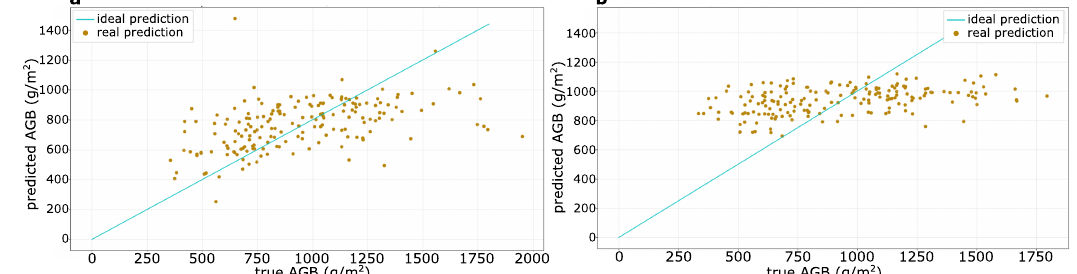
Figure 11. The AGB predictions for the wheat crops at a 0.35 m 2 resolution that were produced by the ERT model compared to those that were produced by the linear model (baseline): ( a ) the regression performance of the ERT model using the testing dataset ( R 2 = 0.20; RMSE = 288 g/m 2 ; MAE = 216 g/m 2 ; MAPE = 23%); ( b ) the regression performance of the linear model (baseline) using the testing dataset ( R 2 = 0.14; RMSE = 304 g/m 2 ; MAE = 254 g/m 2 ; MAPE =